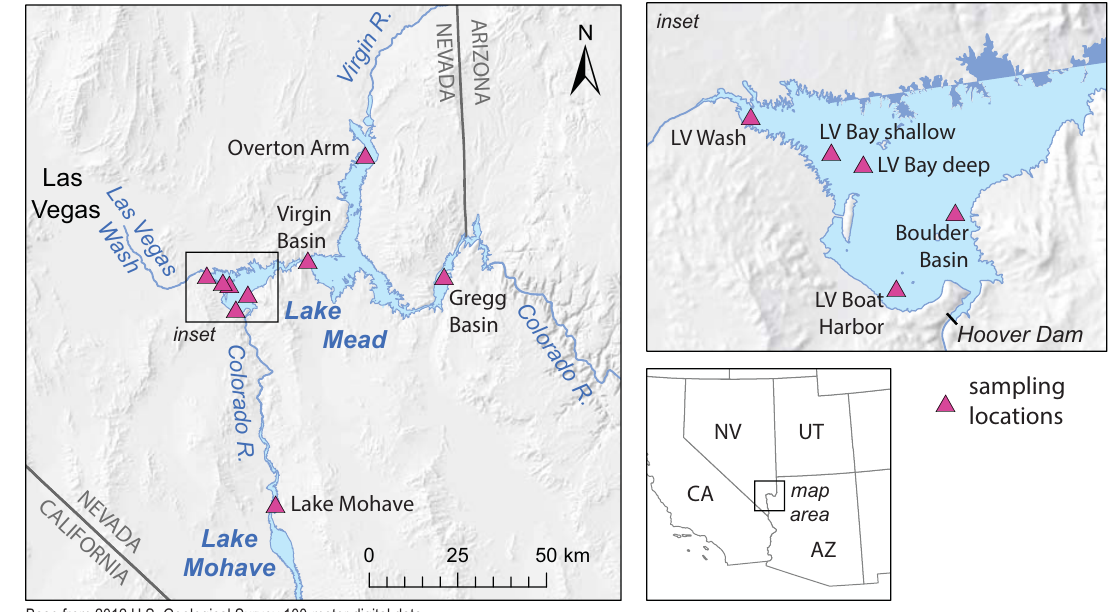
Fig 1. Sampling locations in Lake Mead and Lake Mohave. Lake boundaries are from the U.S. Geological Survey National Hydrography Dataset and are based on full-pool conditions, giving the false appearance that the Las Vegas Wash sampling location was in Lake Mead; at the time of sampling, the water level in Lake Mead was ~43 m below full pool, and the Las Vegas Wash sampling location was riverine. Hillshades are from U.S. Geological Survey 100-meter digital data. LV, Las